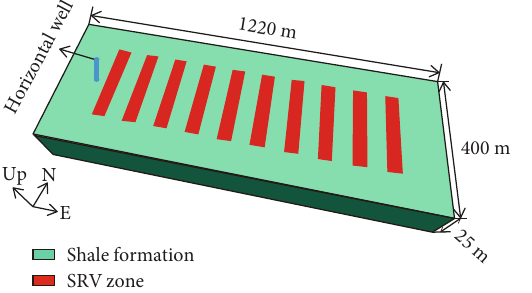
Figure 2: Numerical simulation model of multistage fracturing of horizontal well in the shale gas reservoir.